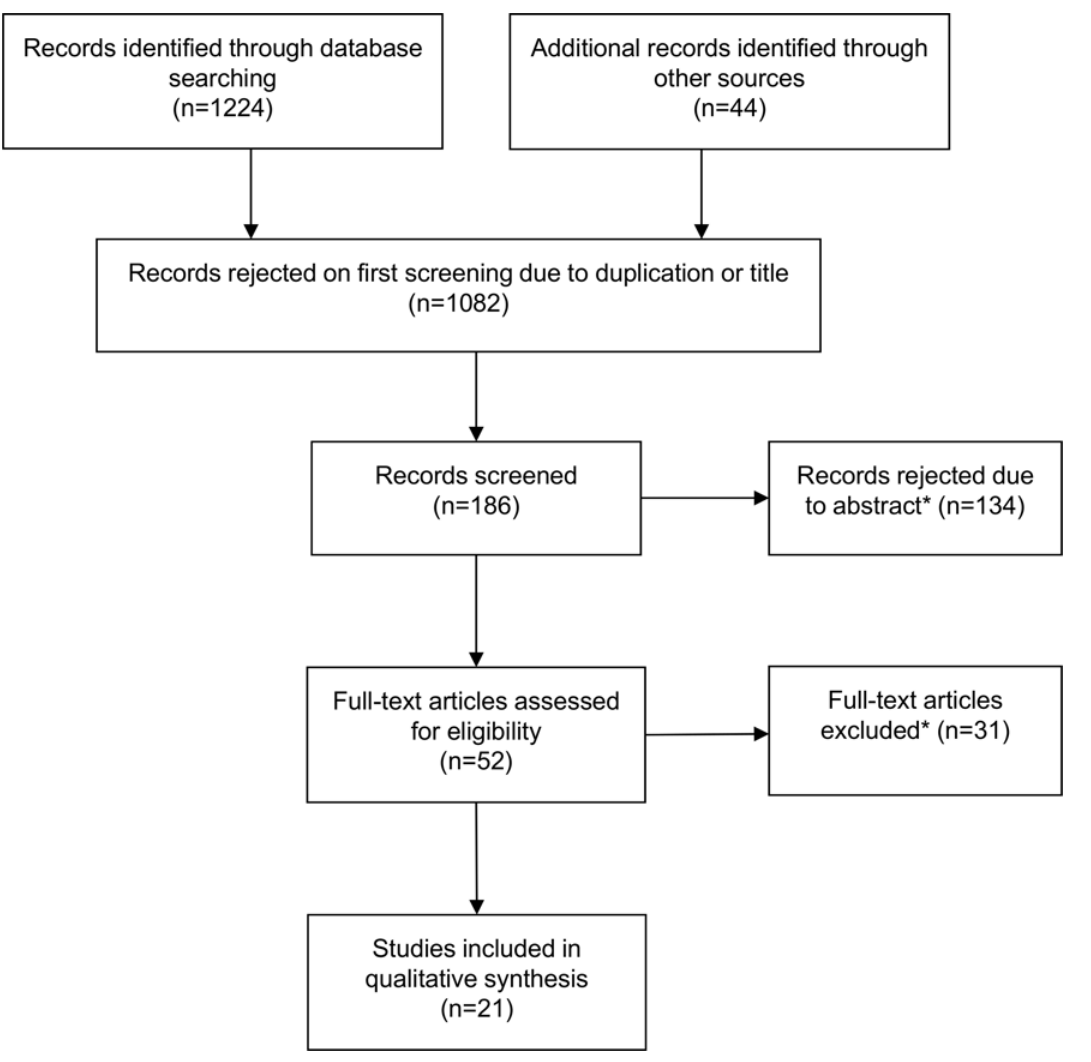
Fig 1. Flowchart of search results. * Studies excluded because of method, participants or